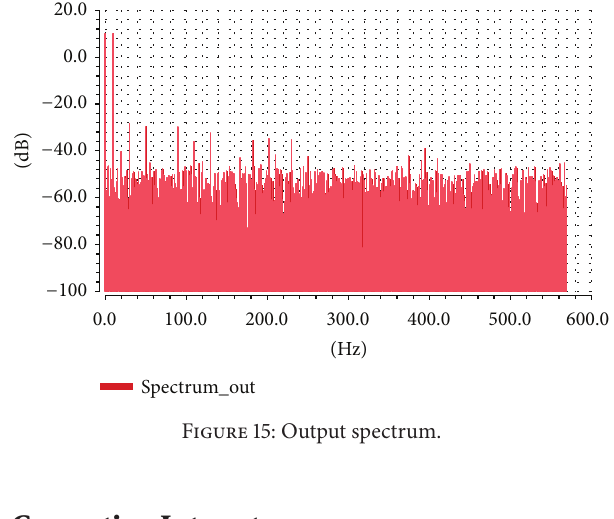
Figure 15: Output